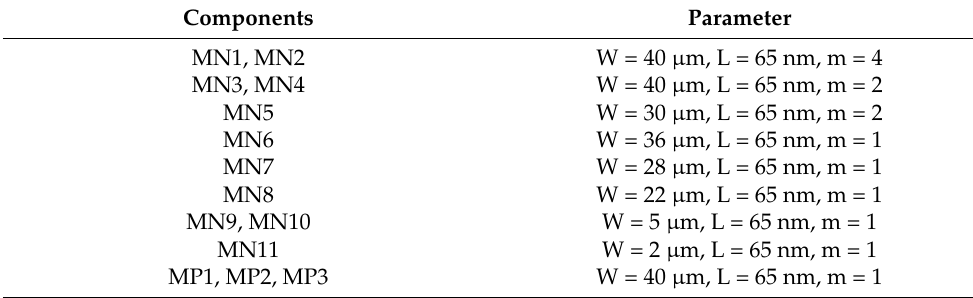
Table 5. Transistor sizes of the proposed RF